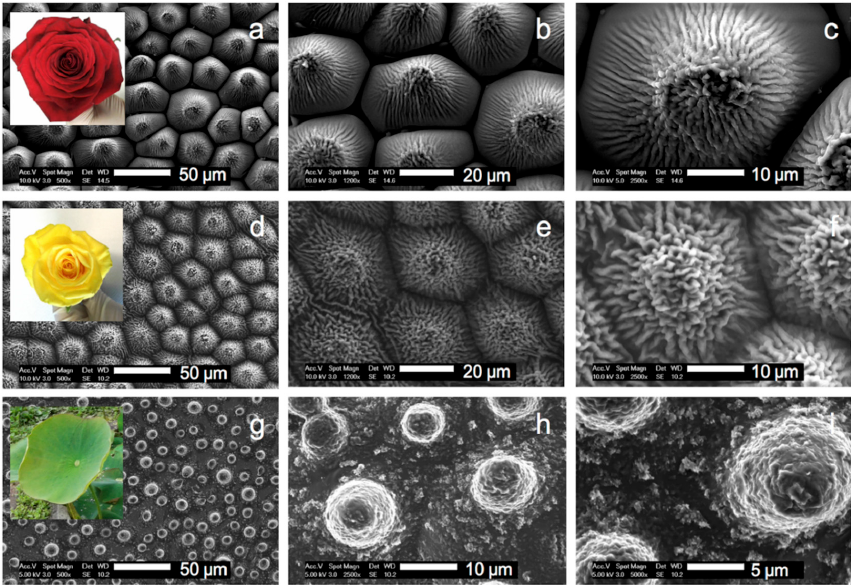
Figure 5. Electron micrographs at three different magnifications of HBP replica of a red rose petal ( a – c ); a yellow rose petal ( d – f ) and a lotus leaf ( g – i ). The insets show the pictures of the three plants used in this work.